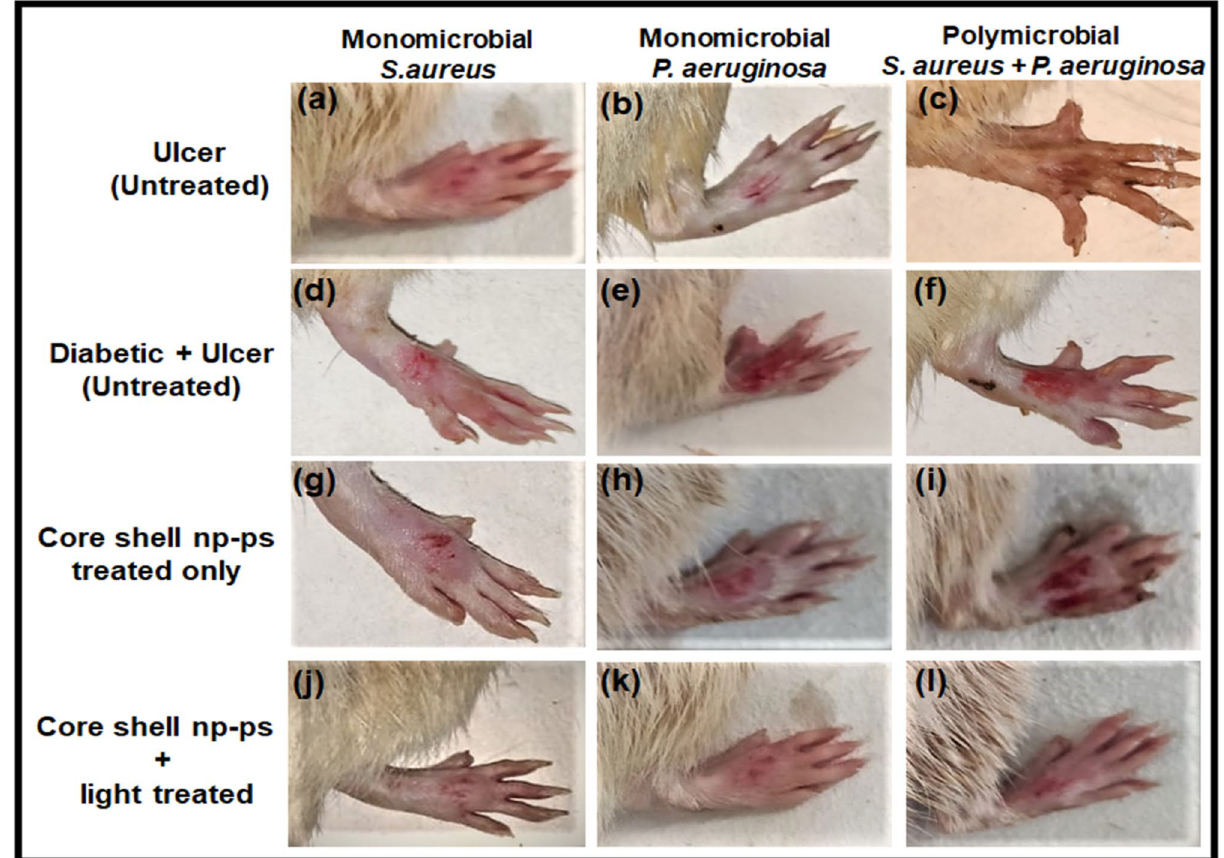
Figure 9. Photographic image of wistar rats: Untreated foot ulcer ( a )–( c ), untreated foot ulcer with diabetes ( d )–( f ), diabetic foot ulcer after applying TBO–chit–Au–AgNPs ( g )–( i ) and diabetic foot ulcer after